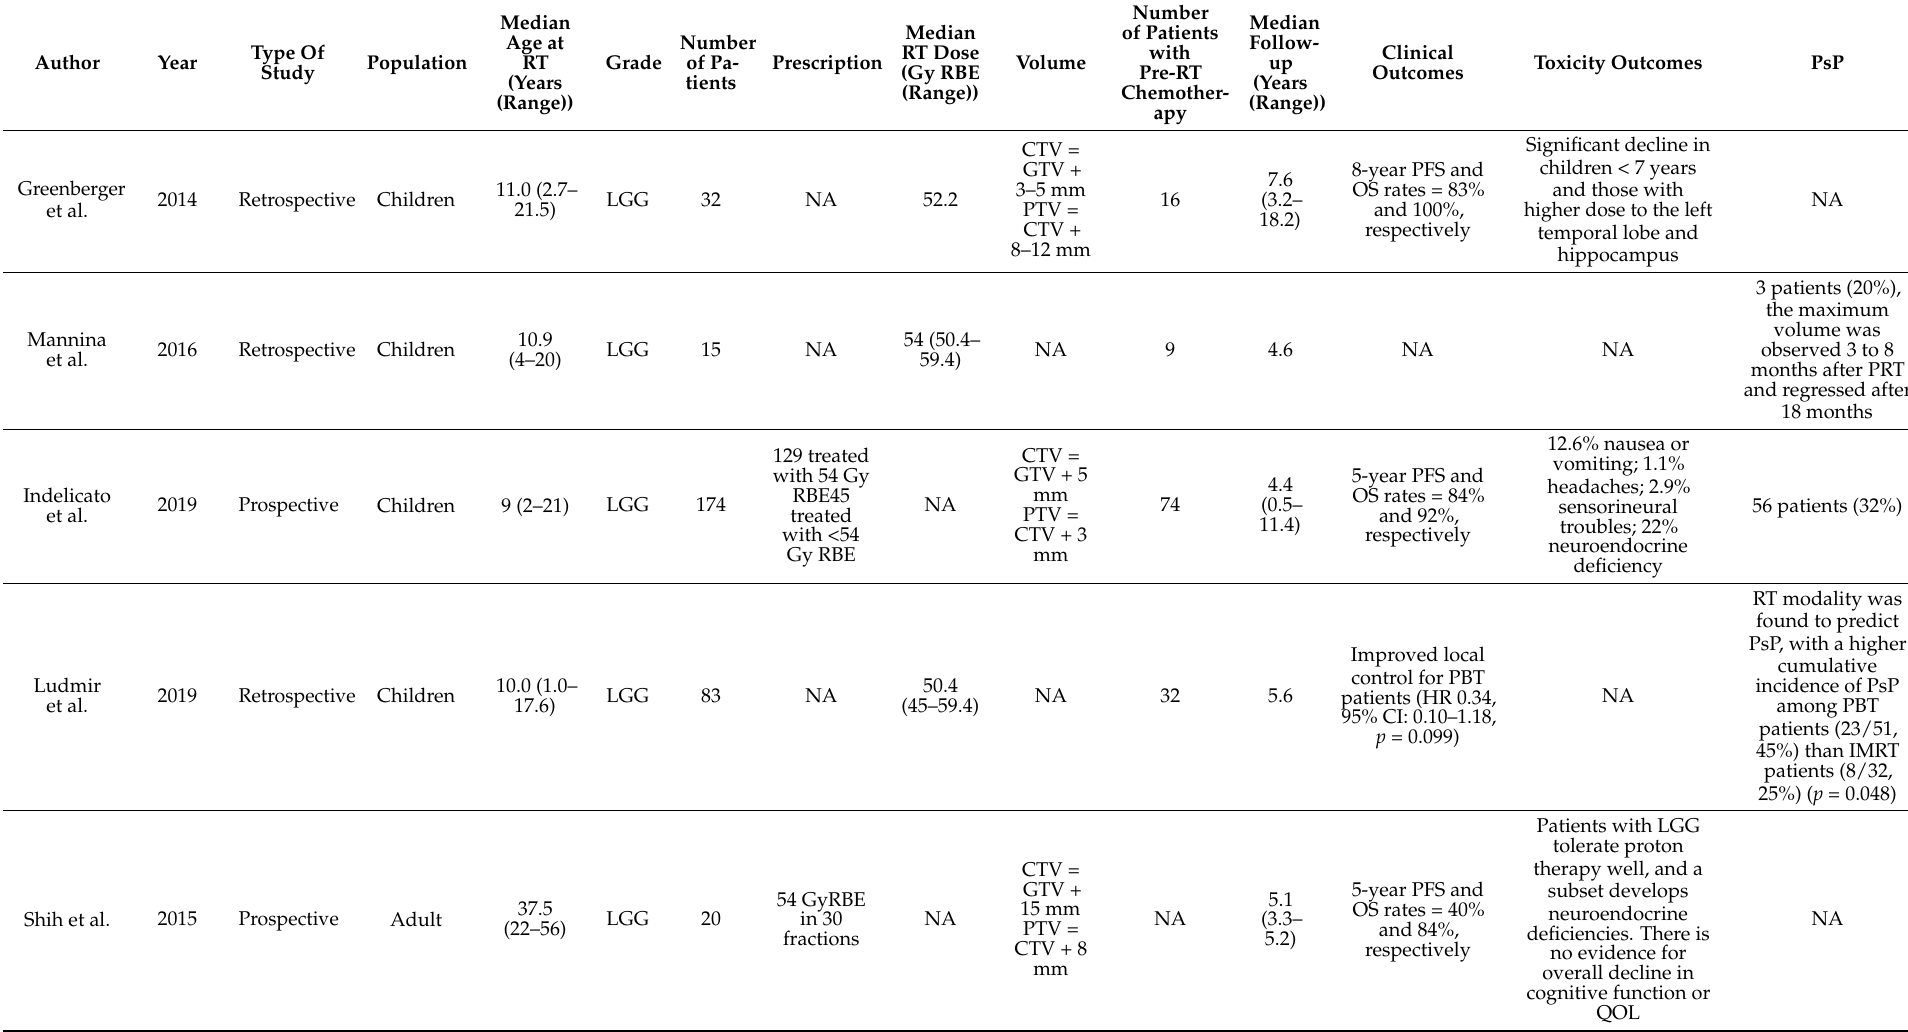
Table 2. Clinical and toxicity